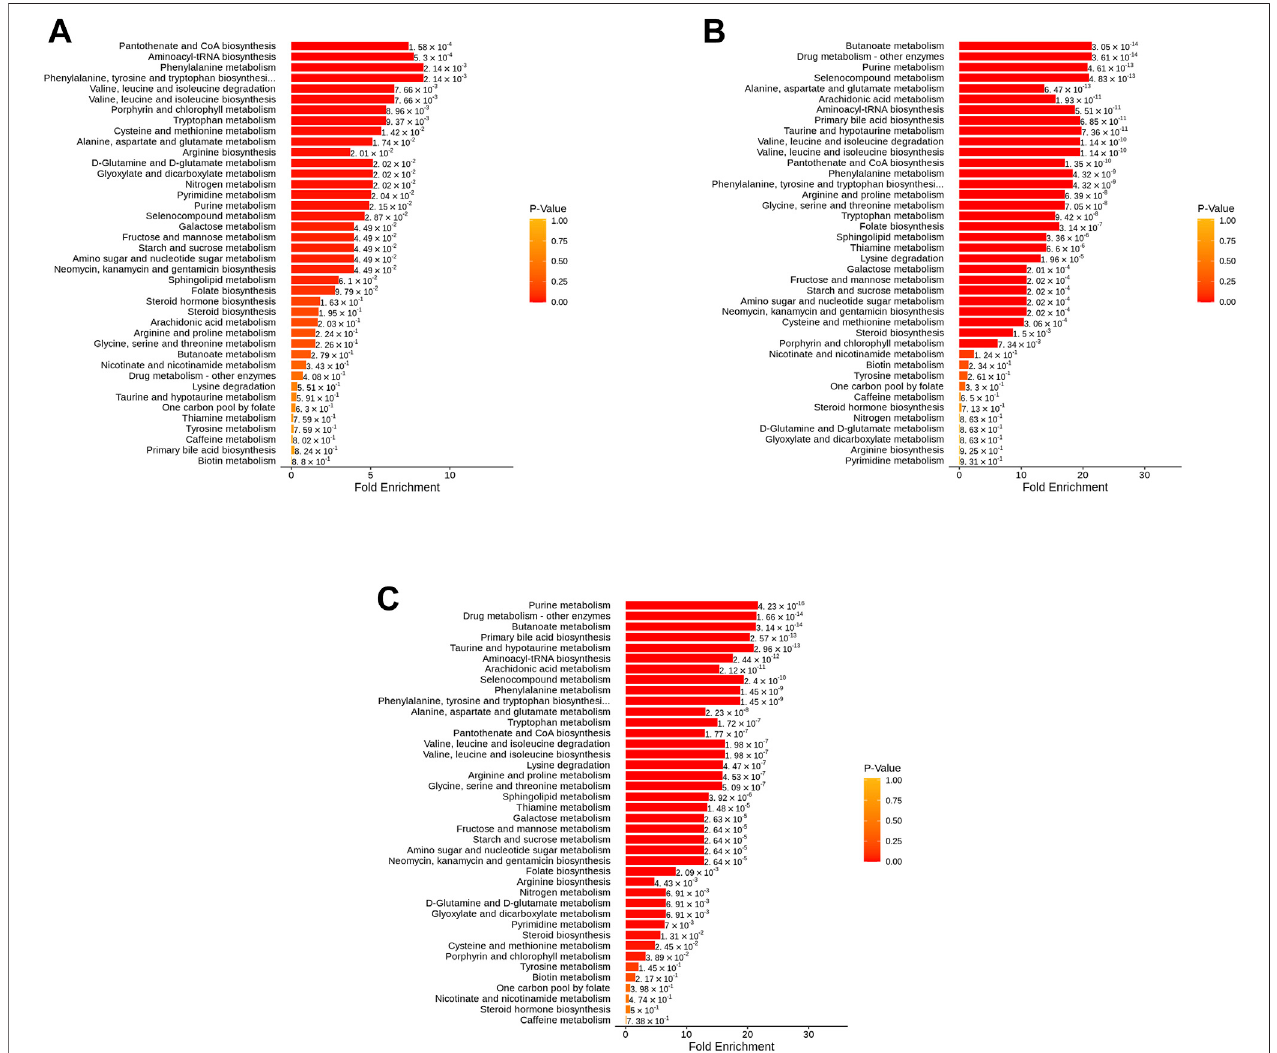
FIGURE 5 | MSEA of differential metabolites. ( (A) ZA vs. ZB; (B) ZA vs. ZC; (C) ZB vs. ZC; The color of the dot represents p -value).